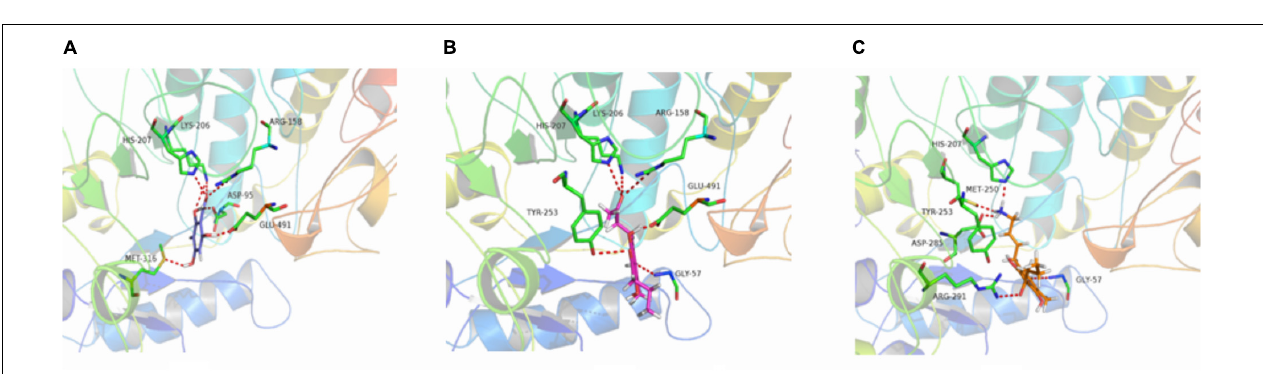
FIGURE 7 | 3D docking conformation of compounds with 1SQC: (A) 3D docking conformation of compound b with 1SQC; (B) 3D docking conformation of compound e with 1SQC; (C) 3D docking conformation of compound g with 1SQC.